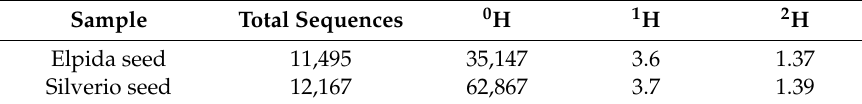
Table 1. Average diversity estimates of the different communities studied.